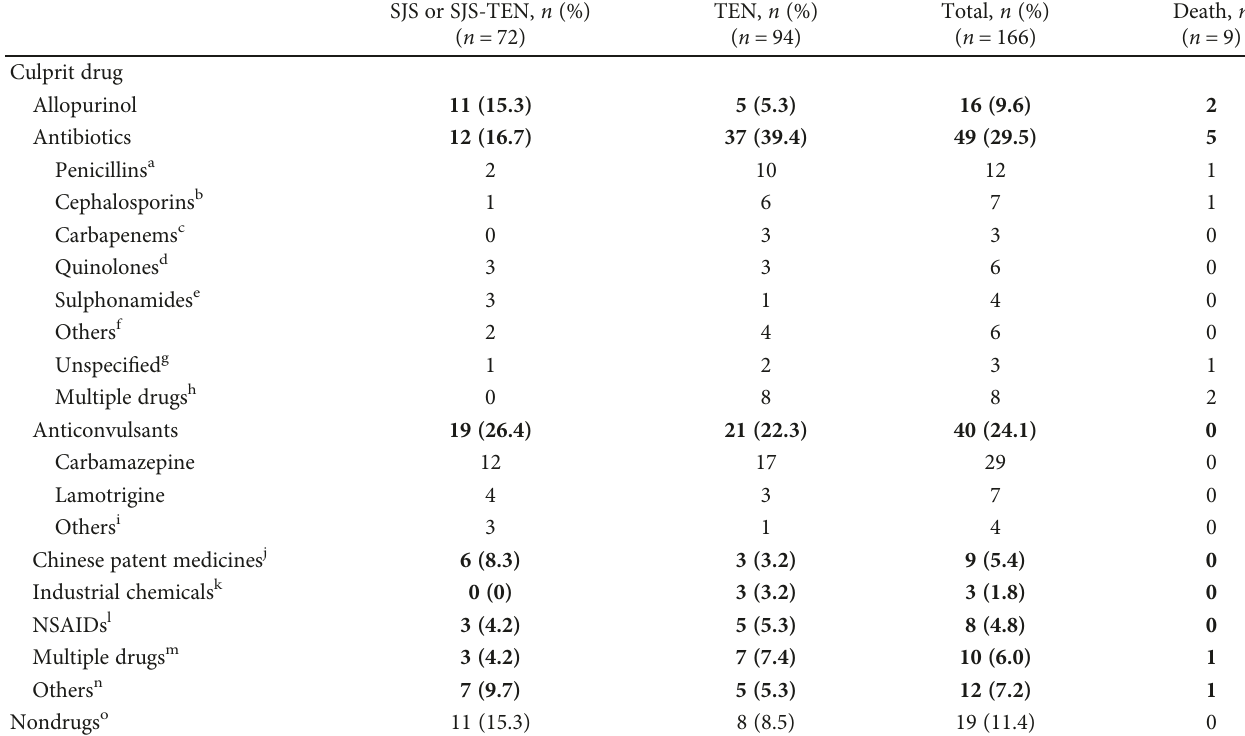
Table 2: Drug causality of SJS/TEN in